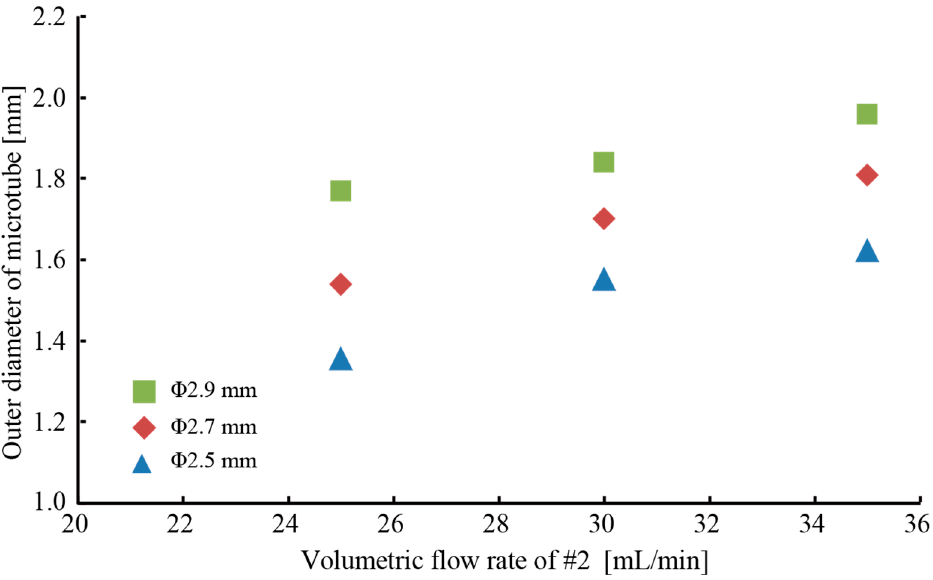
Figure 6. Relationship between outer diameter of microtube and volumetric flow rate of fluid #2.